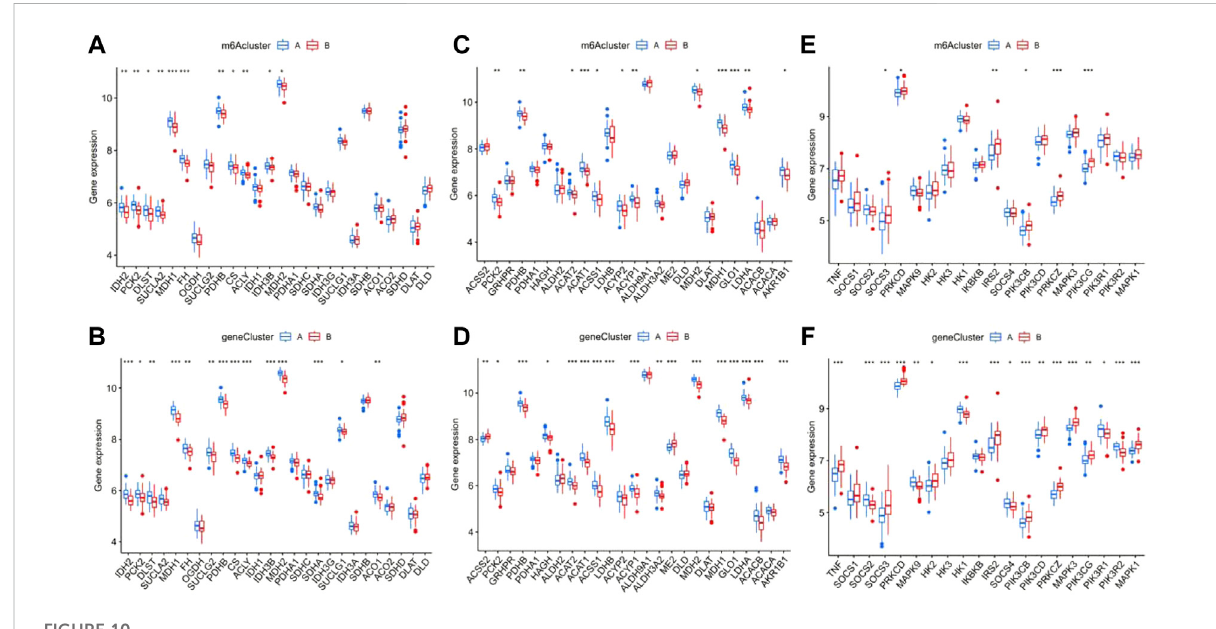
FIGURE 10 Analysis of the correlation between the different m6A and gene clusters in patients with epilepsy with the tricarboxylic acid cycle (TAO), pyruvate metabolism, and type II diabetes. The difference in expression of tac-related genes in m6A clusters (A) and gene clusters (B) , pyruvate metabolism (C,D) , and type II diabetes (E,F) .* p < 0.01, ** p < 0.001, *** p <